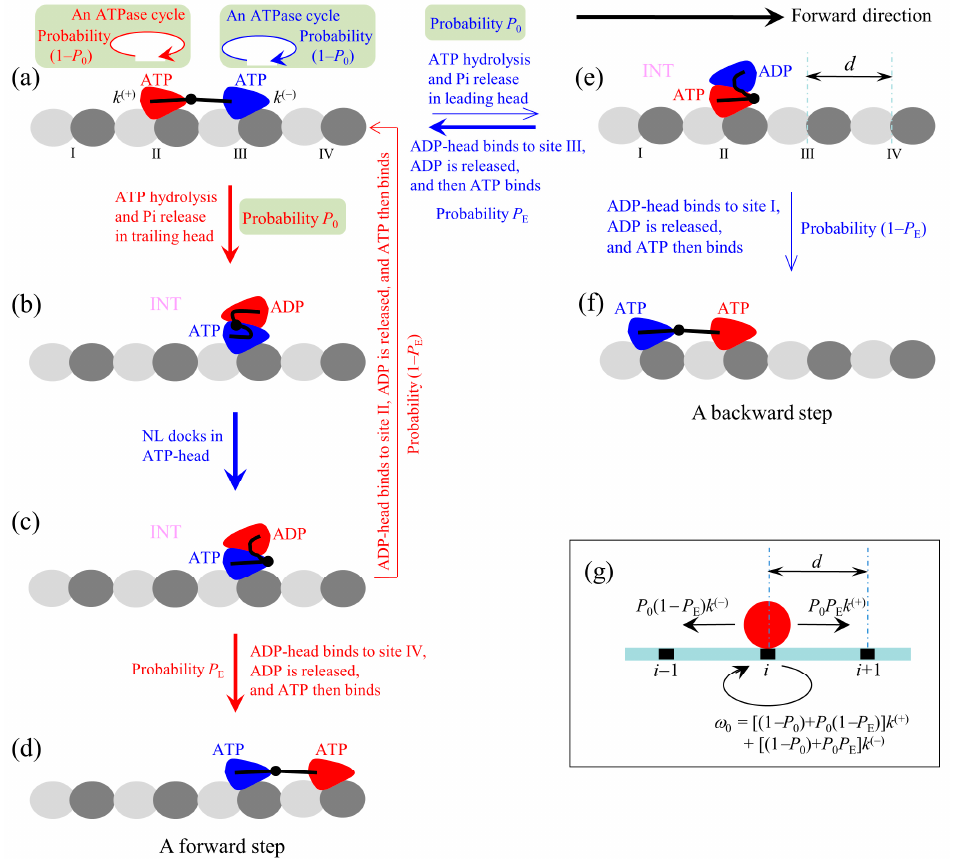
Figure 2. The model of stepping of kinesin dimer at saturating ATP. ( a – f ) The pathway for the chemomechanical coupling (see text for detailed description). The thickness of the arrow represents the magnitude of the transition probability under no external force. ( g ) The simplified model derived from the pathway shown in (a–f). The red circle represents the center of mass of the motor. The positions of binding sites on the MT filament are denoted by …, ( i –1), i , ( i +1), ….